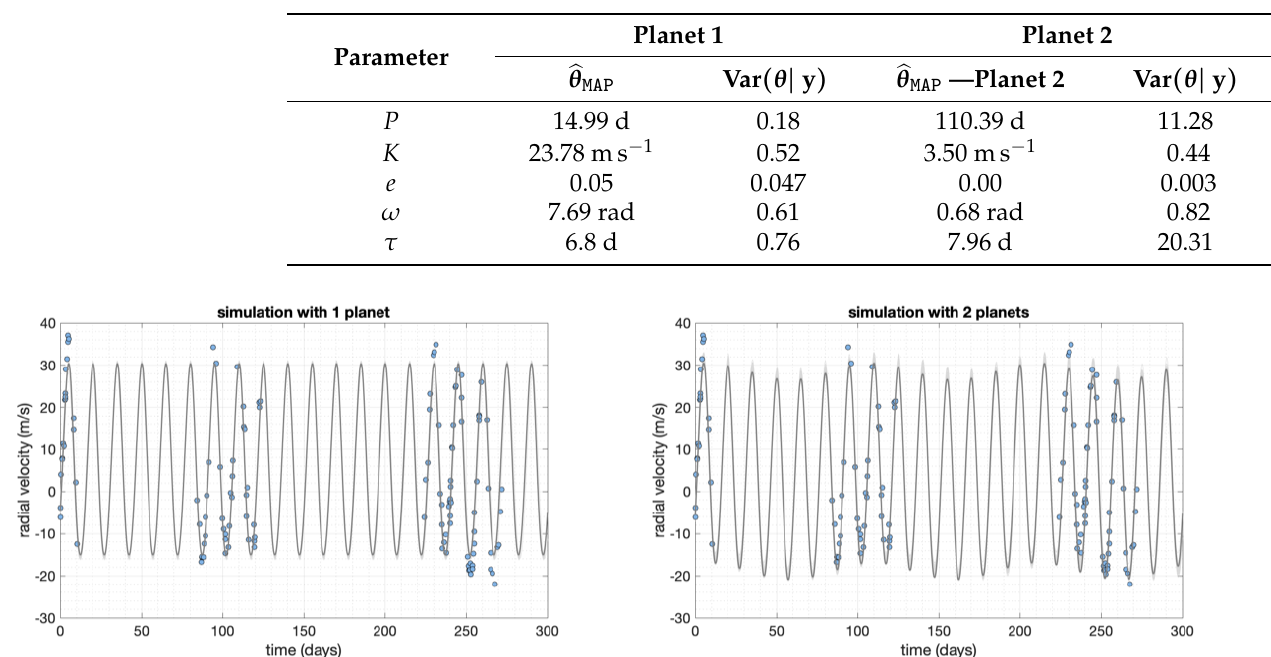
Figure 5. Comparison of the results of the ATAIS algorithm with the simulations (blue dots). Left panel shows, in gray, the radial velocity curve for (cid:98) θ MAP using a model with one planet. Right panel is like left panel but considering a model with two